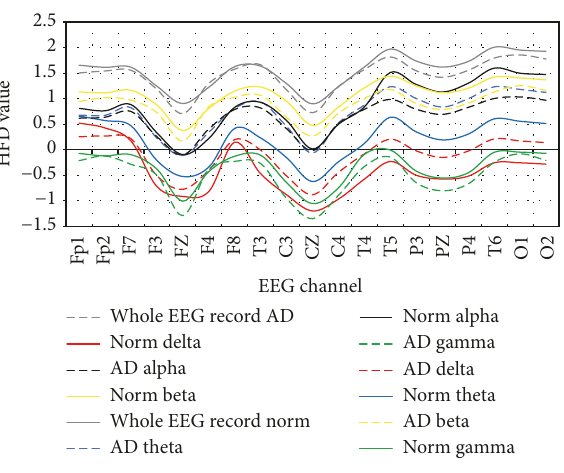
Figure 3: EEG biomarkers for